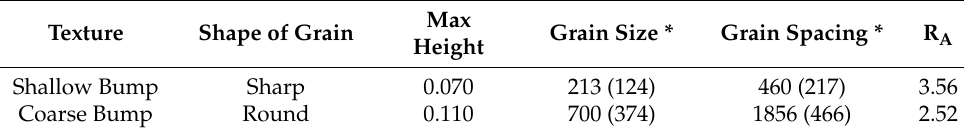
Table 1. Parameters of surface features (in µ